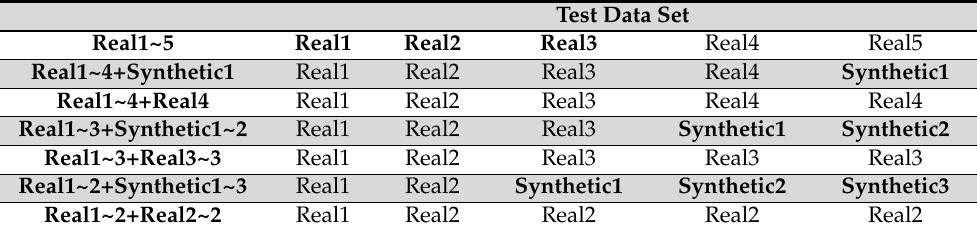
Table 4. Experimental database for comparing user recognition